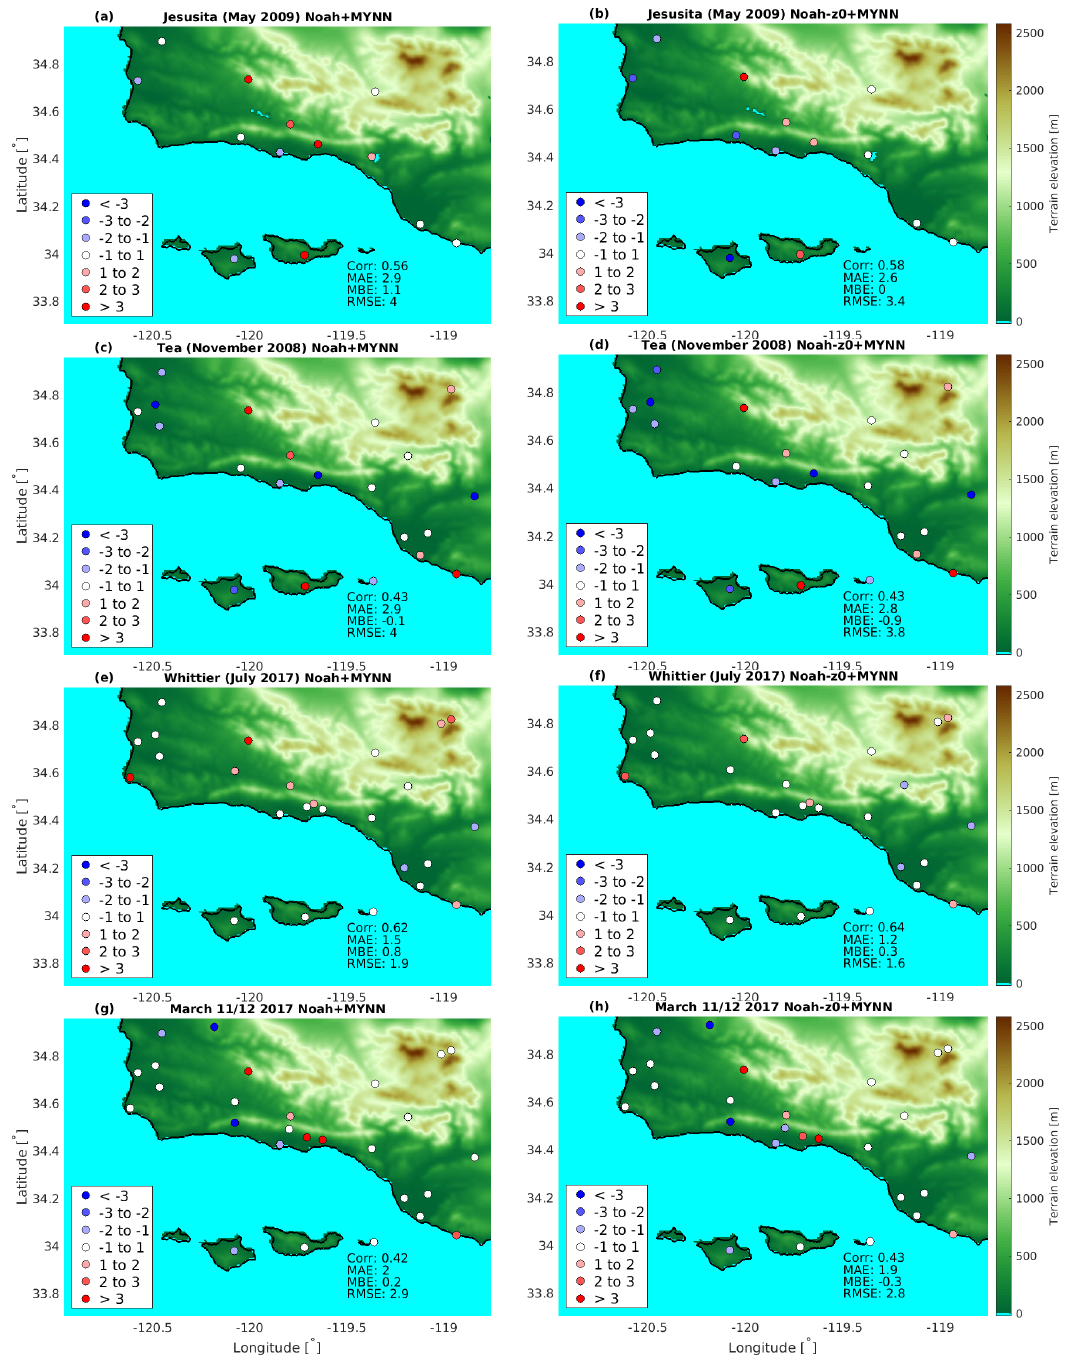
Figure 5. Event-averaged MBE of wind speed (m s − 1 ) for the ( a , c , e , g ) standard Noah and ( b , d , f , h ) modified Noah- z 0 configurations for the Sundowner events indicated in the panel titles. Each panel also shows the event- and network-averaged values for correlation, MAE, MBE, and